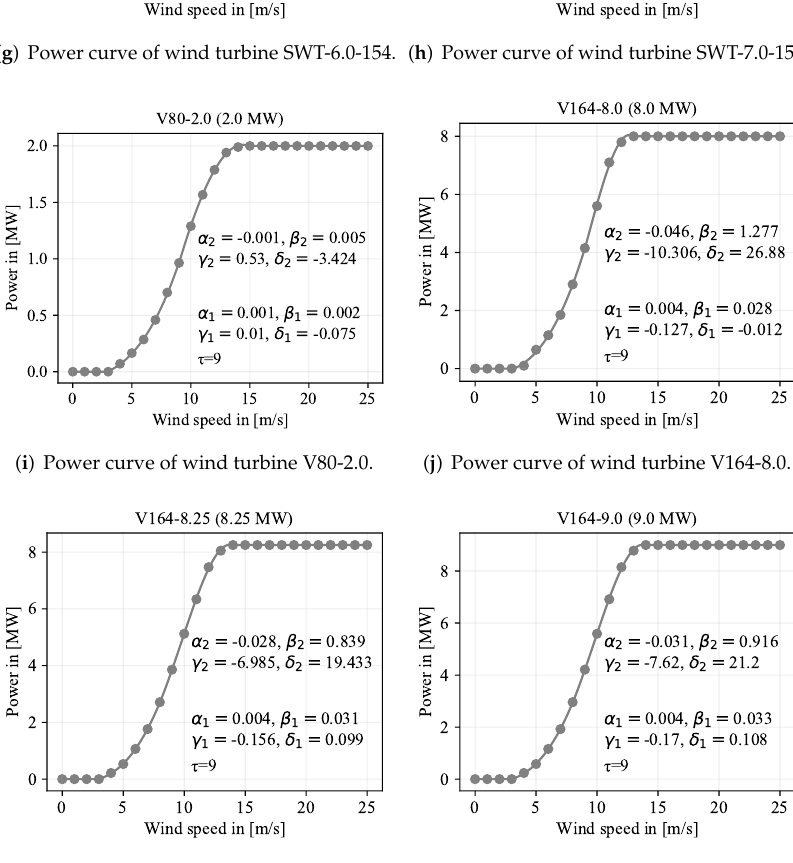
( l ) Power curve of wind turbine V164-9.0 (es- timated from V164-9.5).